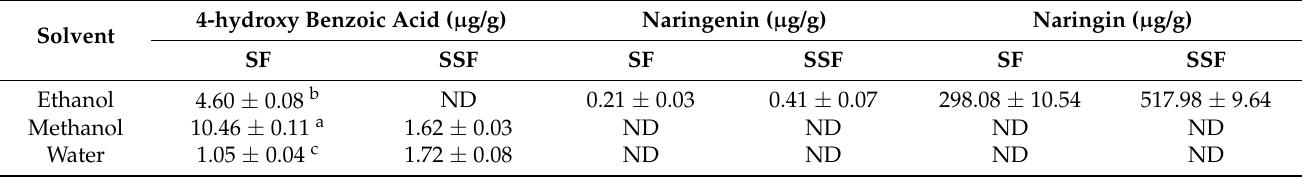
Table 4. Phenolic compound contents in fresh and steamed Sargassum fusiforme extracts.